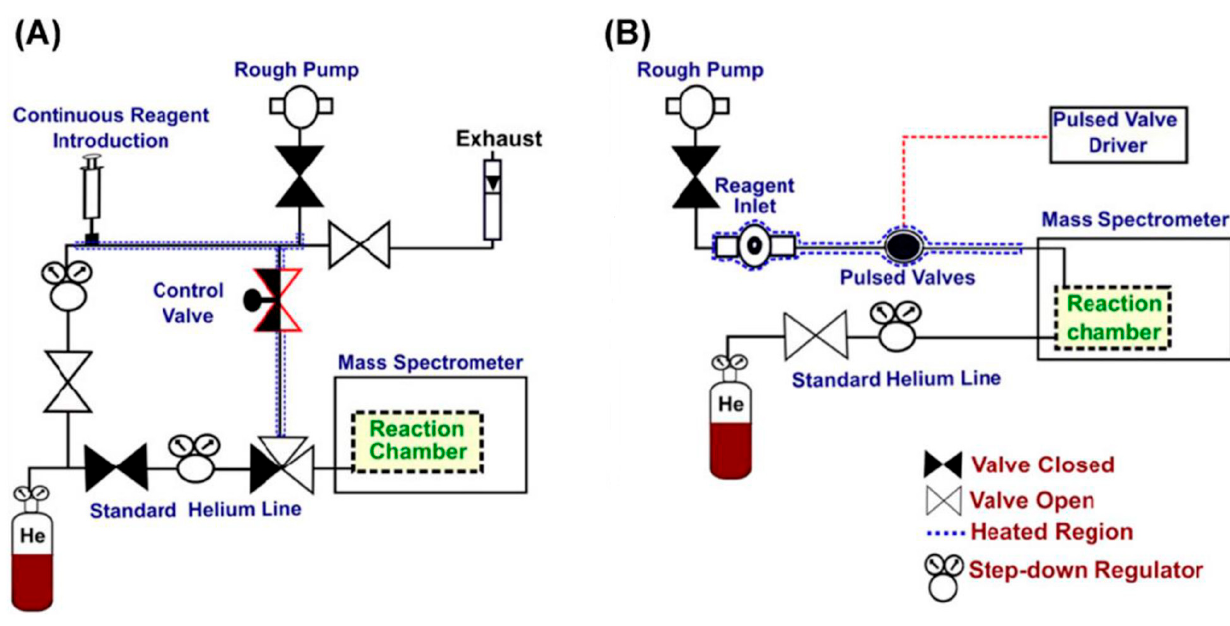
Figure 2. Reagent inlet systems for gas-phase ion-molecule reactions. ( A ) A reagent mixing manifold for continuous reaction kinetics monitoring, and ( B ) a pulsed valve system for fast reagent screening [4]. Adjusted and reprinted with permission from John Wiley and Sons.